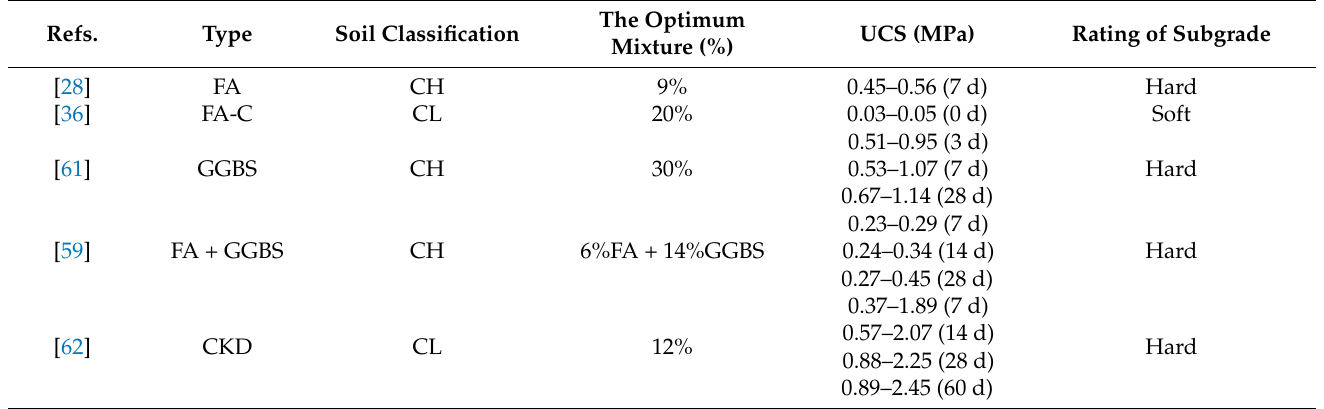
Table 1. Summary of the UCS of expansive soil stabilized by industrial solid waste.